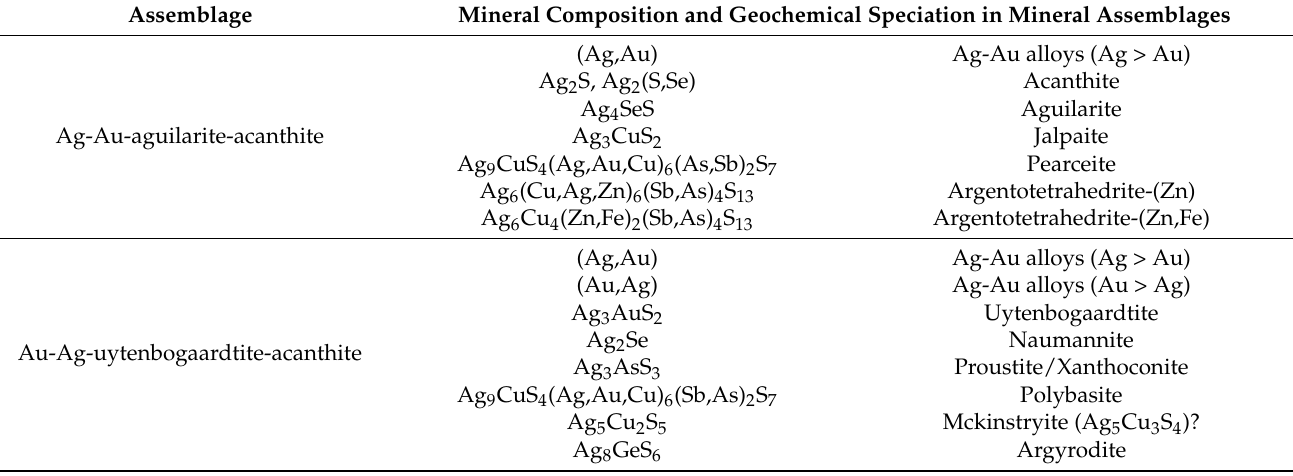
Table 2. Mineral assemblages of the gold-silver association in the Rodnikovoe deposit.